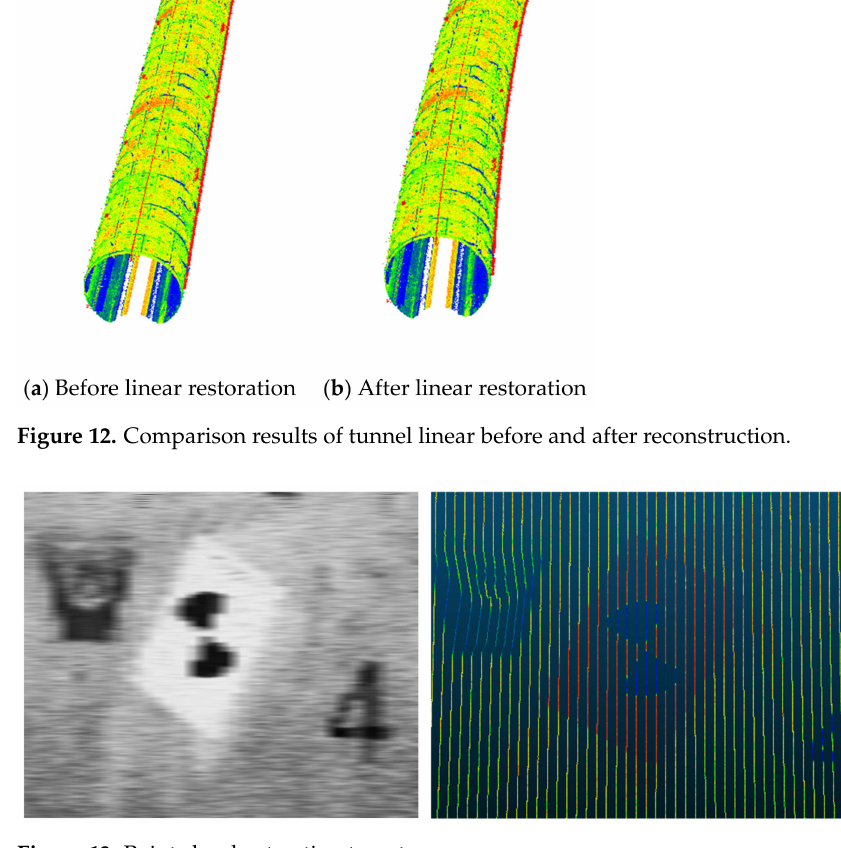
Figure 13. Point cloud extraction